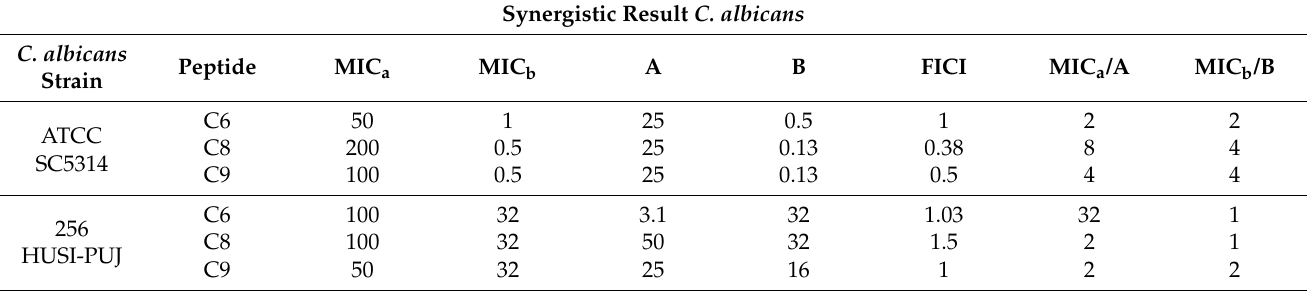
Table 4. Effect of combining the chimeric peptides with FLC on C. albicans SC5314 and 256 HUSI/ PUJ